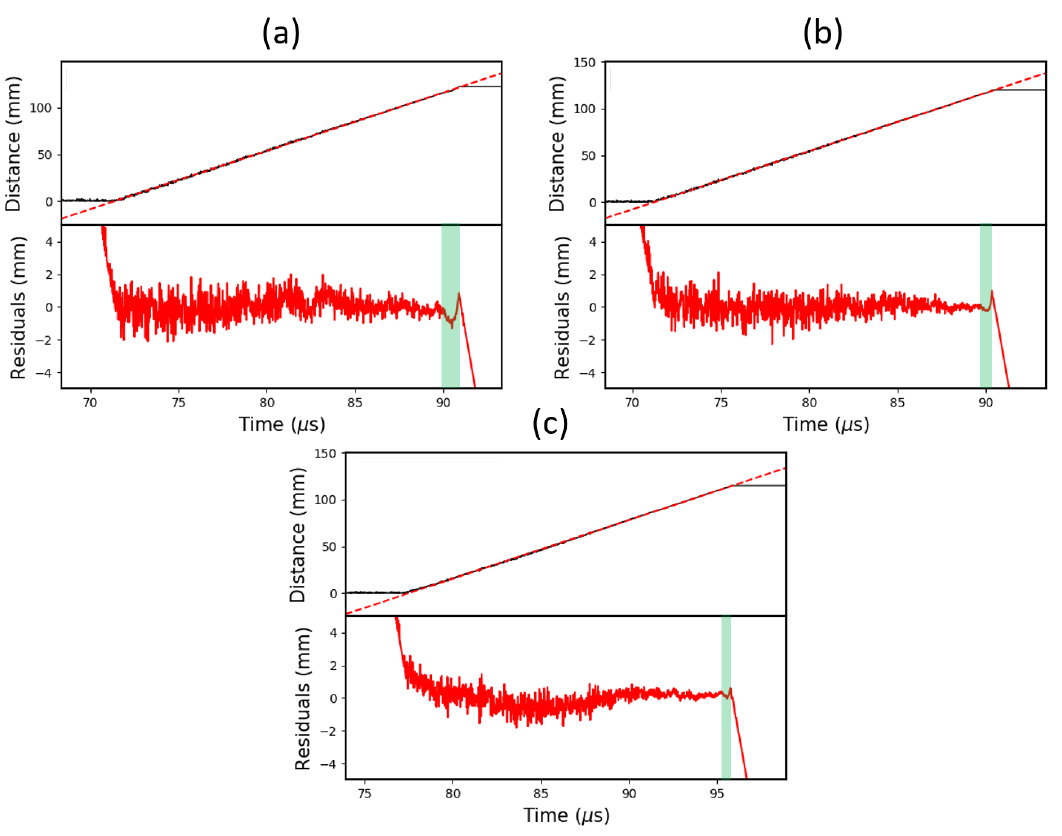
Figure 13. Graphs showing the calibrated and low-pass filtered (20 MHz) data from three 60–68% reflectivity CFBG tests with: ( a ) 5 nm bandwidth; ( b ) 10 nm bandwidth; and ( c ) 20 nm bandwidth. Each CFBG is approximately 120 mm long. Plotted underneath are the residuals from the linear regression. The non-linear region, highlighted in green, is longest for the 5 nm bandwidth